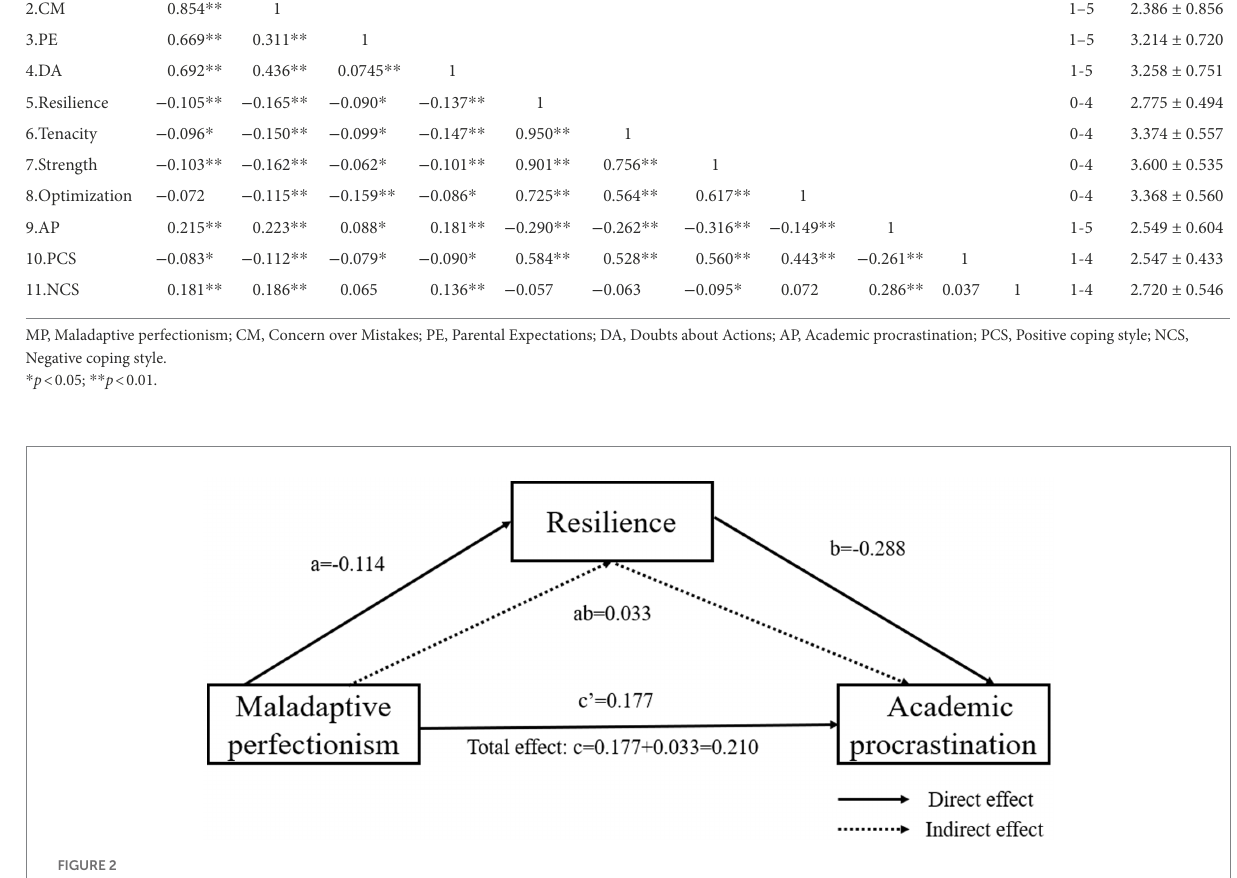
FIGURE 2 Mediating effect of